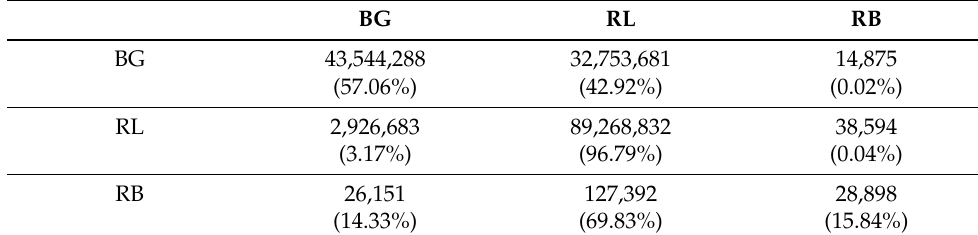
Figure 17. Representative failed Cityscapes images: source images ( left ), GT ( center ), and re- sults ( right ). Table 5. Confusion matrix for Rice blast test subset images